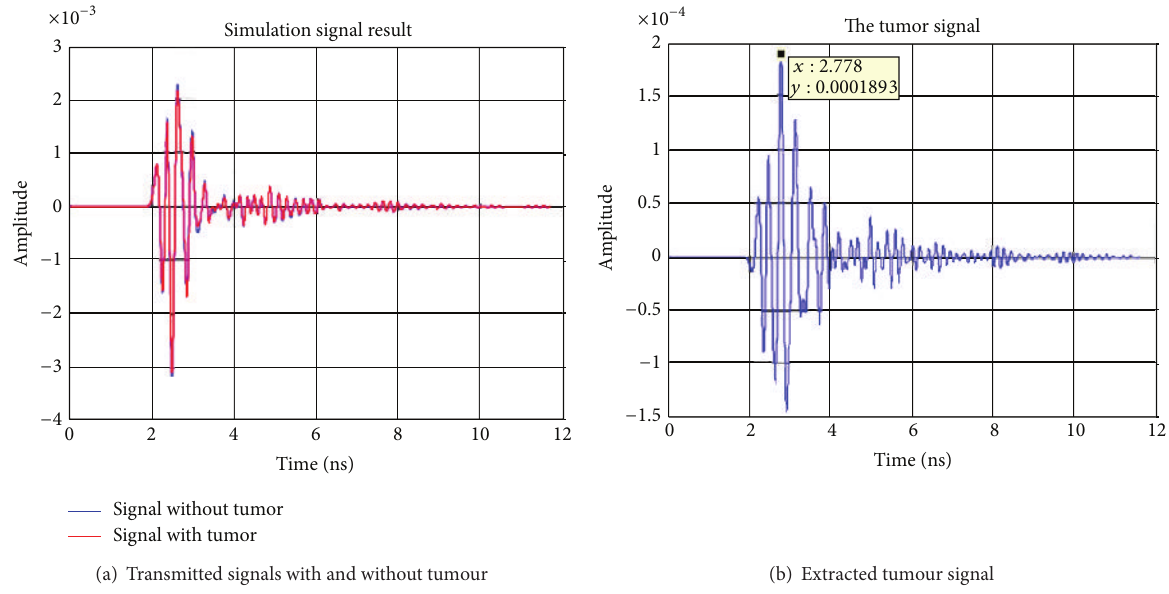
Figure 6: Simulation signal results transmitting from antenna 1 to antenna 3.